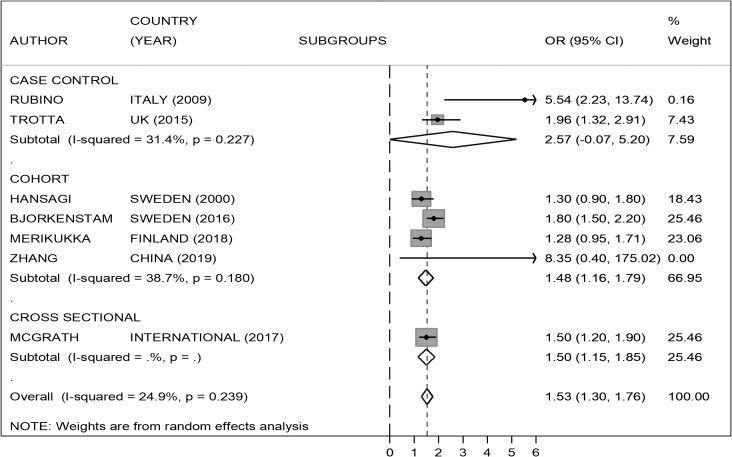
Risk of psychosis in children of separated parents excluding studies where the exposure was the separation between parent and child for different reasons, including, but not exclusively, parental separation.